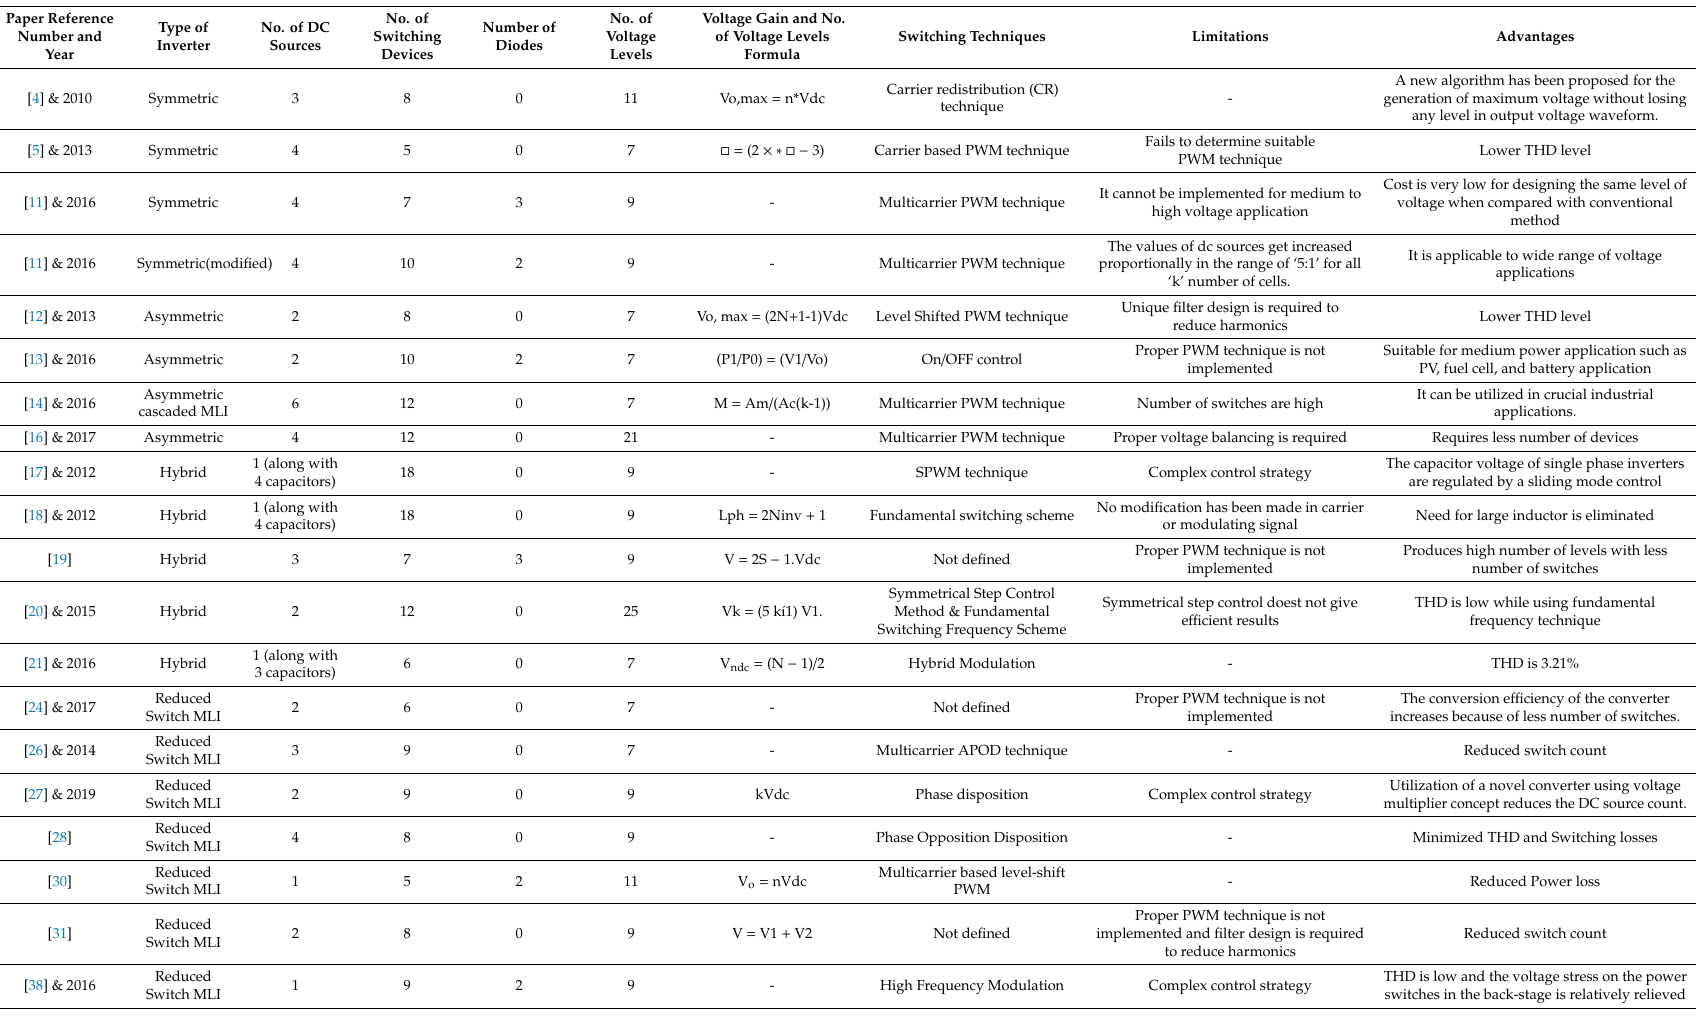
Table 1. Classification of MLI based on its number of elements and